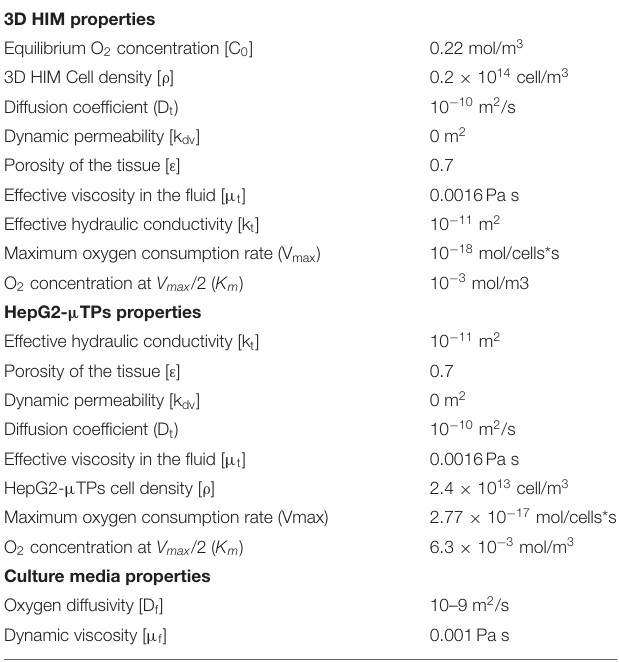
TABLE 1 | Mathematical modeling